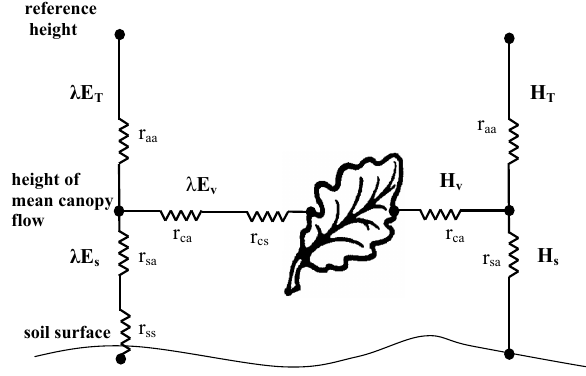
Fig. 5. Schematic of the Shuttleworth-Wallace (1985) two- component canopy